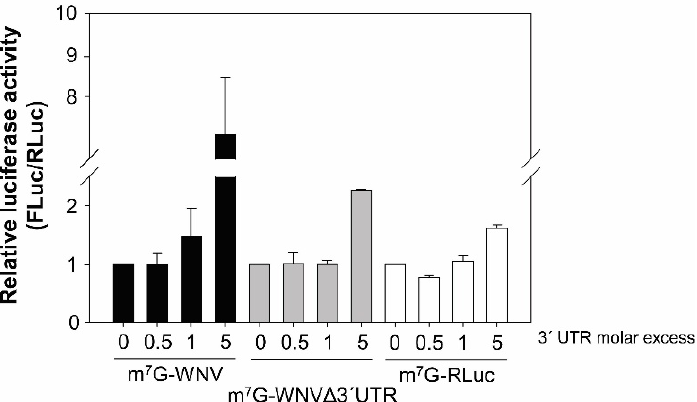
Figure 4. The genomic 3 ′ UTR of WNV enhanced translation in trans. Vero cells were cotransfected with the m 7 G-WNV or m 7 G-WNV Δ 3 ′ UTR RNA constructs, and m 7 G-RLuc RNA, in the presence of increasing molar excess of the genomic 3 ′ UTR WNV RNA fragment and decreasing amounts of the RNA-100 to compensate for the total RNA load in the transfection mix. Translation activity was determined as described in Figure 1. Values refer to that of the corresponding experiment without the 3 ′ UTR RNA fragment added.